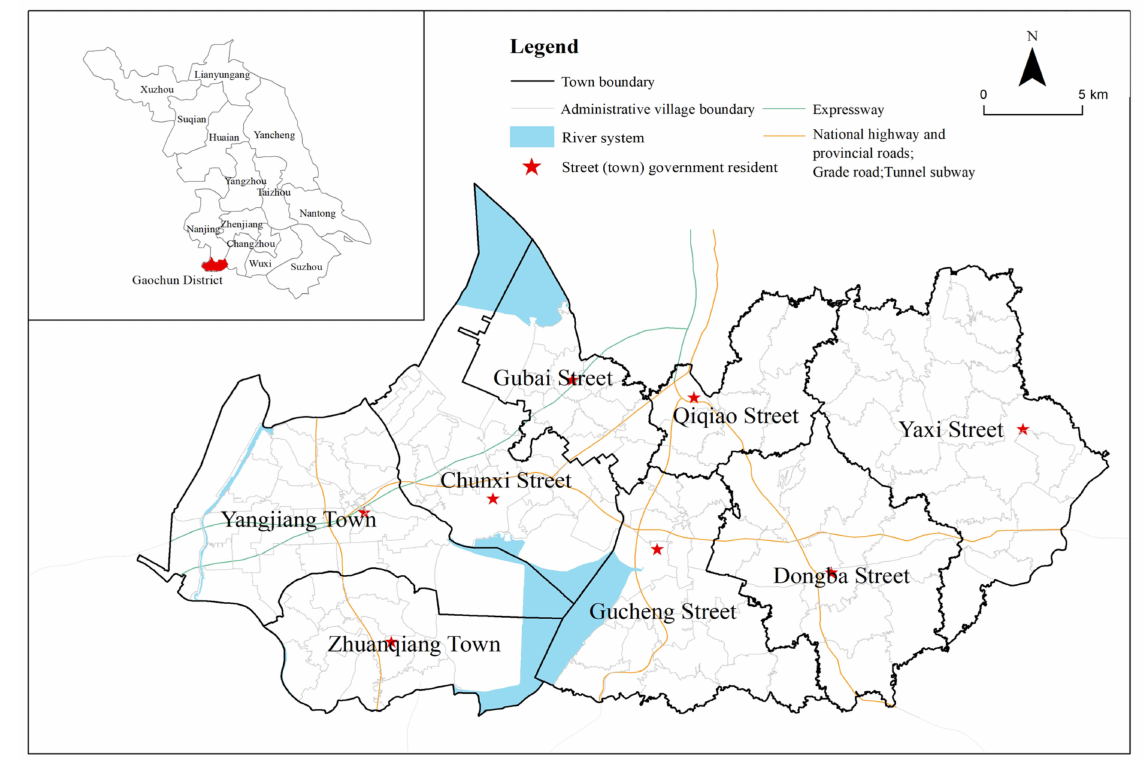
Figure 1. Research